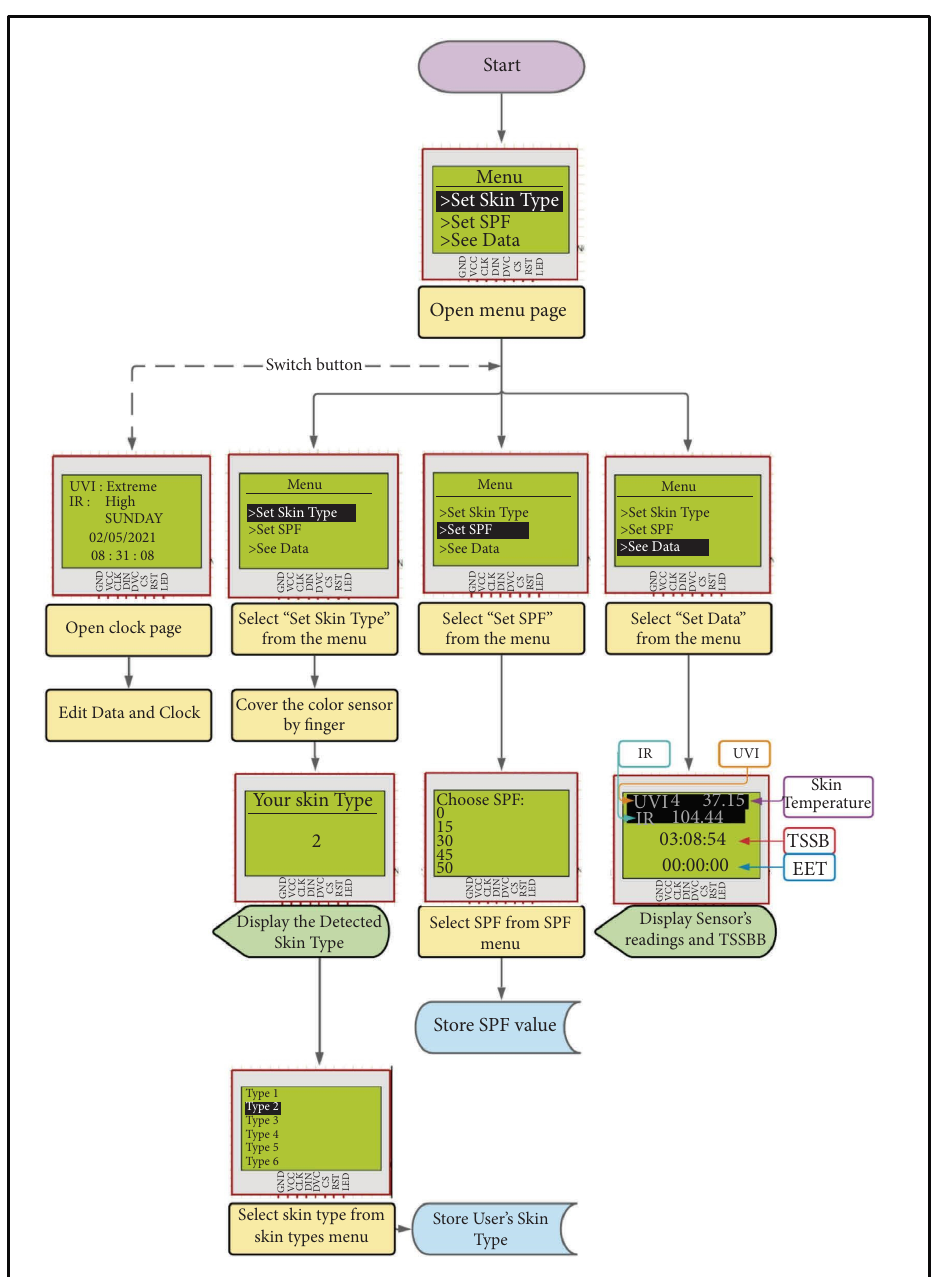
Figure 4: General device operation. Yellow blocks indicate manual operation, pink for input data by sensors, blue for data storage, and green for